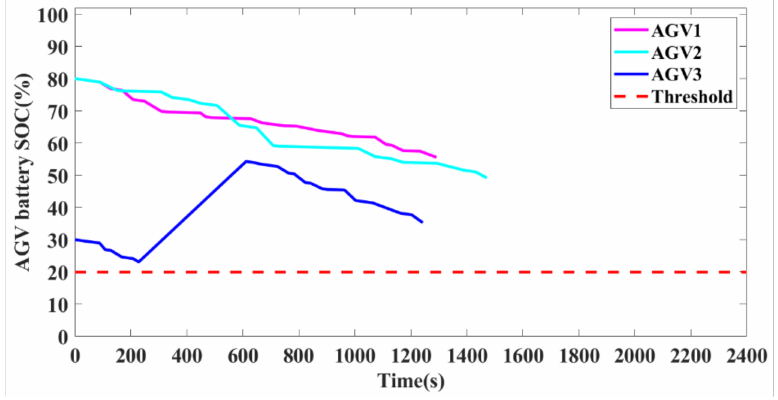
Figure 16. The AGV SOC curve when DTDAS is